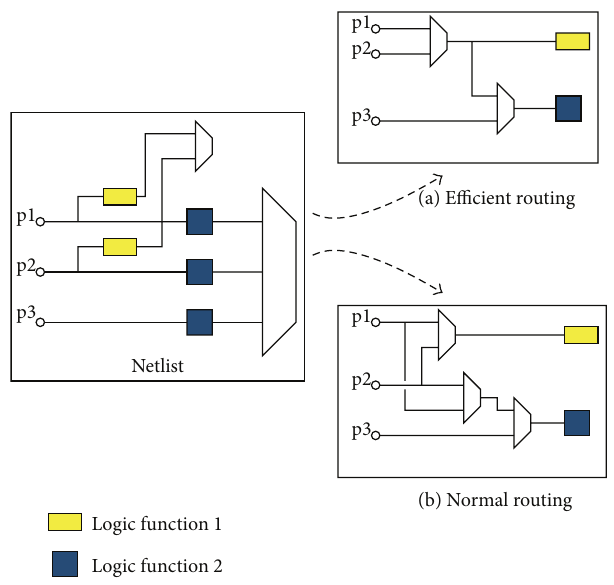
Figure 8: Normal routing versus efficient routing.